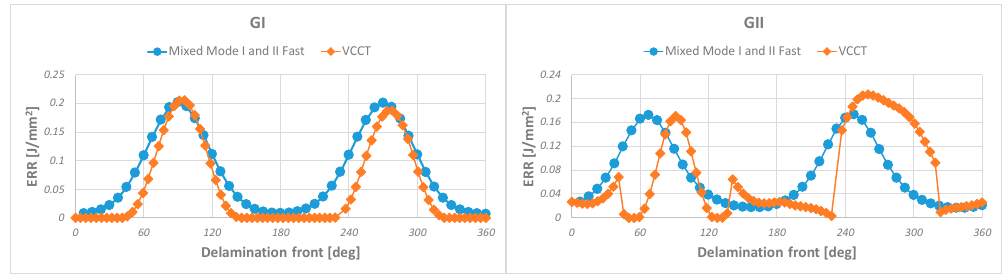
Figure 20. SS#1-comparison between mixed mode I and II fast procedure and VCCT of SERR Figure20. distribution